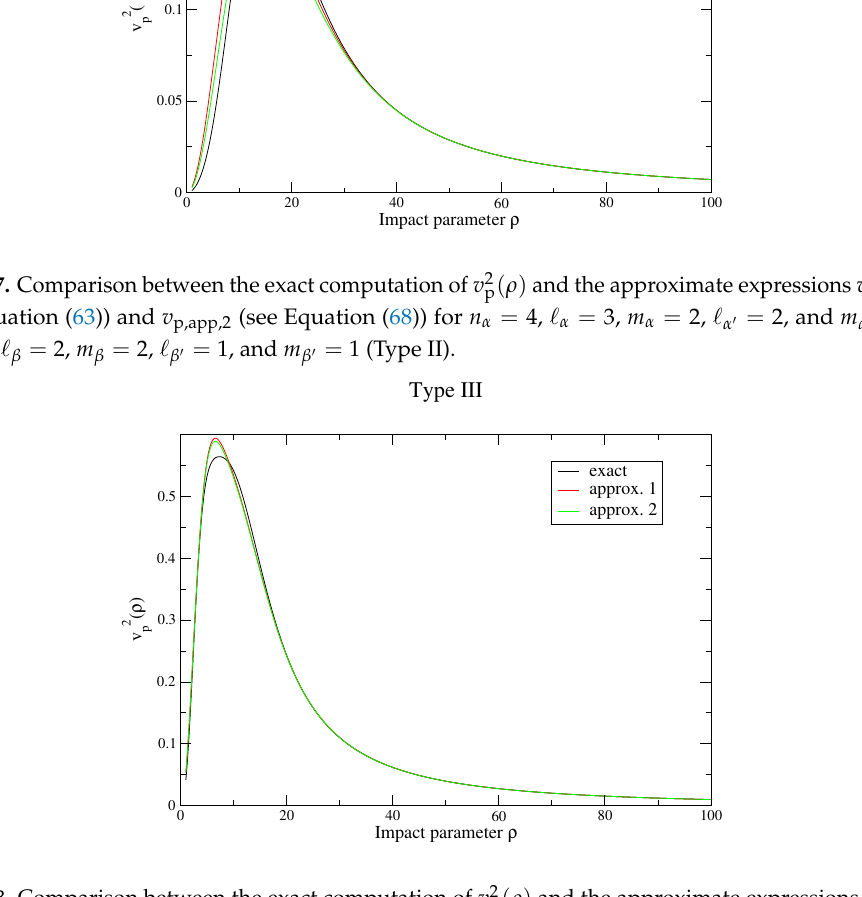
Figure 8. Comparison between the exact computation of v 2 p ( ρ ) and the approximate expressions v p,app (see Equation (63)) and v p,app,2 (see Equation (68)) for n α = 3, (cid:96) α = 1, m α = 1, (cid:96) α (cid:48) = 1, and m α (cid:48) = 1, n β = 2, (cid:96) β = 0, m β = 0, (cid:96) β (cid:48) = 0, and m β (cid:48) = 0 (Type